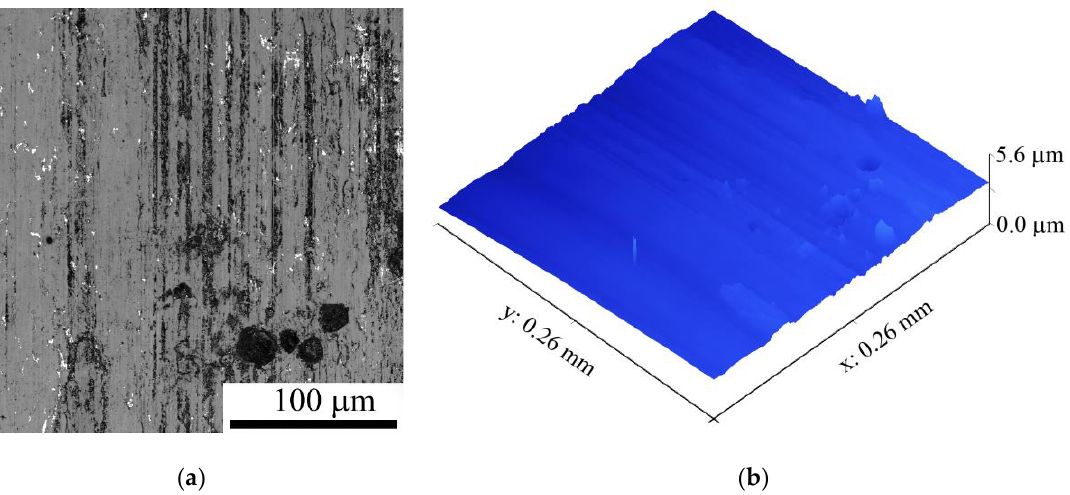
Figure 8. The optical images worn surface ( a ) and 3D map of the worn surface ( b ) of AISI 52,100 counterbody after sliding speed of 3.6 m/s.